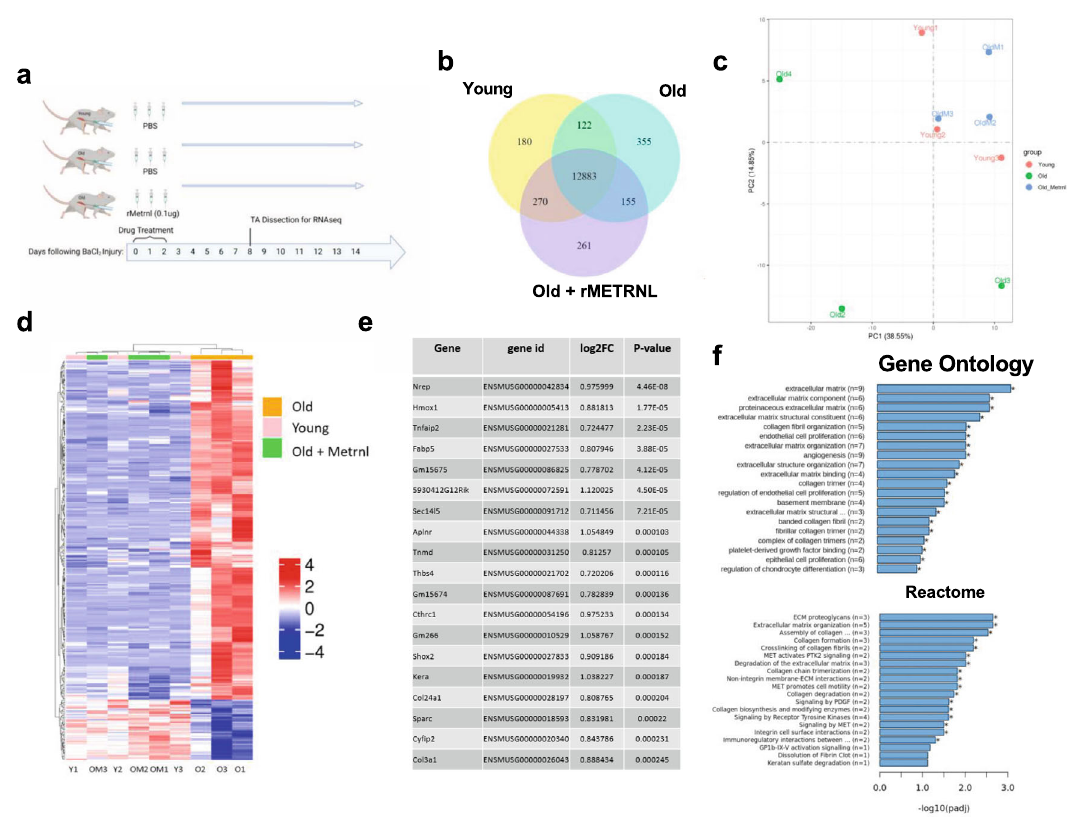
Fig. 4 | rMetrnl rejuvenates the transcriptional pro fi le of aged muscle regen- eration. a Graphical representation of experimental design ( n =3/group). b Venn Diagram of co-expressed transcripts between groups. c 2D Graphical representa- tion of principal component analysis showing top two principal components of transcriptomic data. d Heatmap and dendrogram of transcript ( y axis) expression levelcomparedtomeanexpressionacrossallgroups(colormap)fromeachsample ( x axis). e Top transcripts ranked by signi fi cance and log fold change when